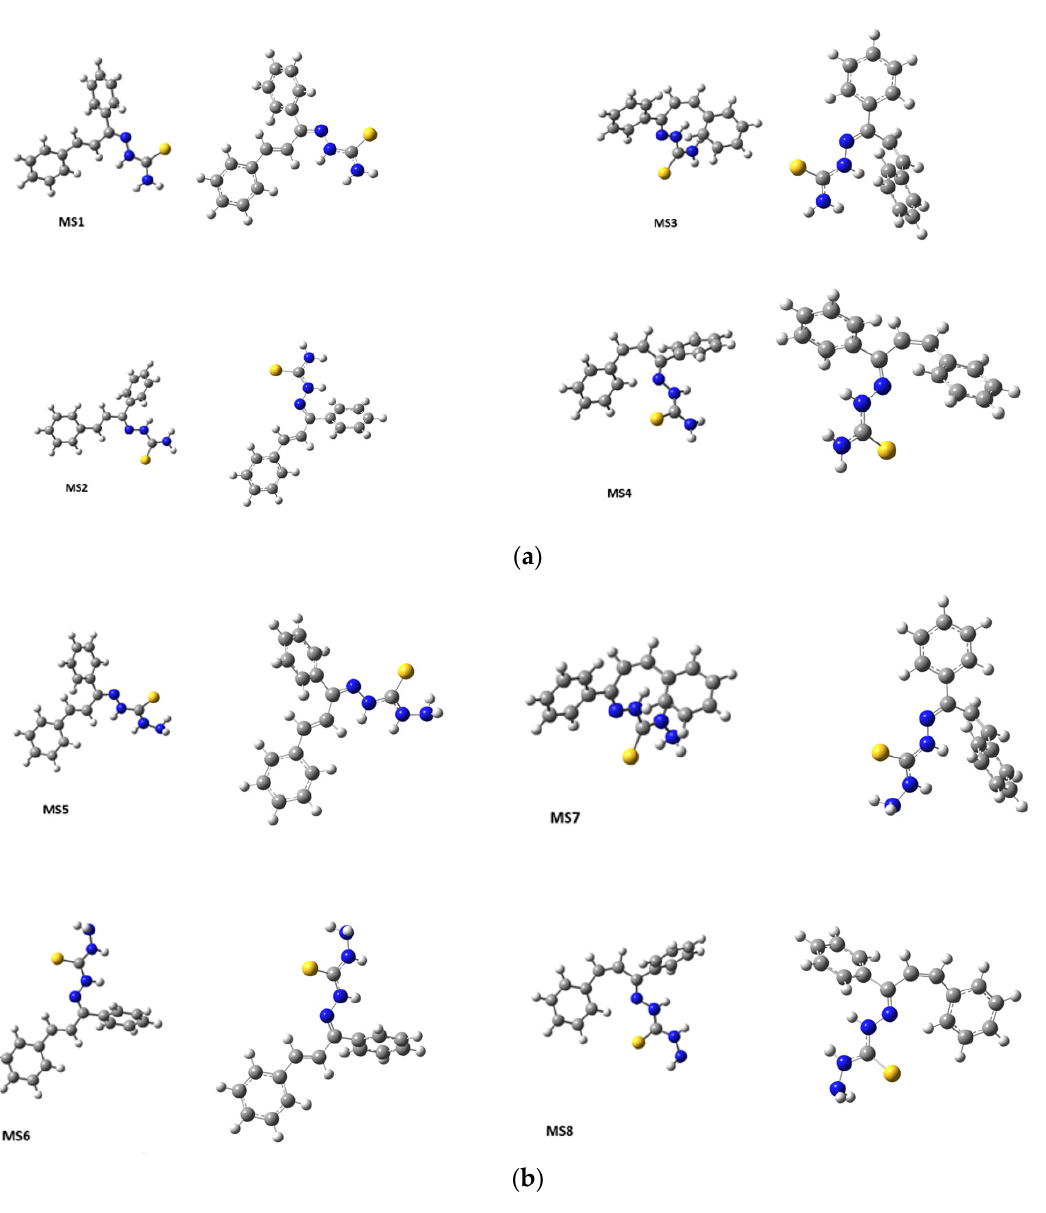
Figure 4. Optimized conformations derived from DFT calculations for ( a ) KKI15 and ( b ) KKI18.